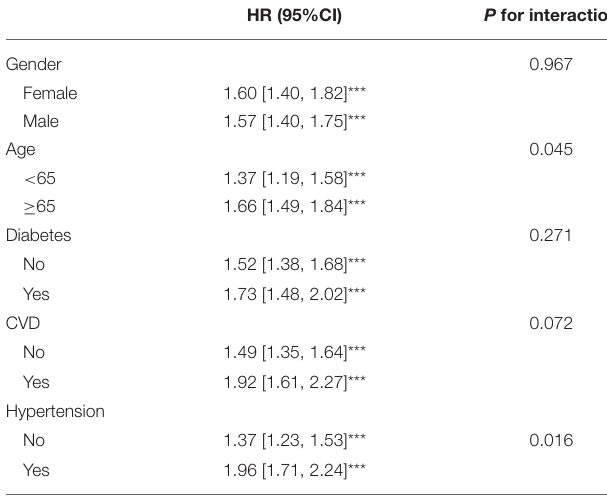
TABLE 3 | Subgroup analysis of association of total bilirubin with all-cause